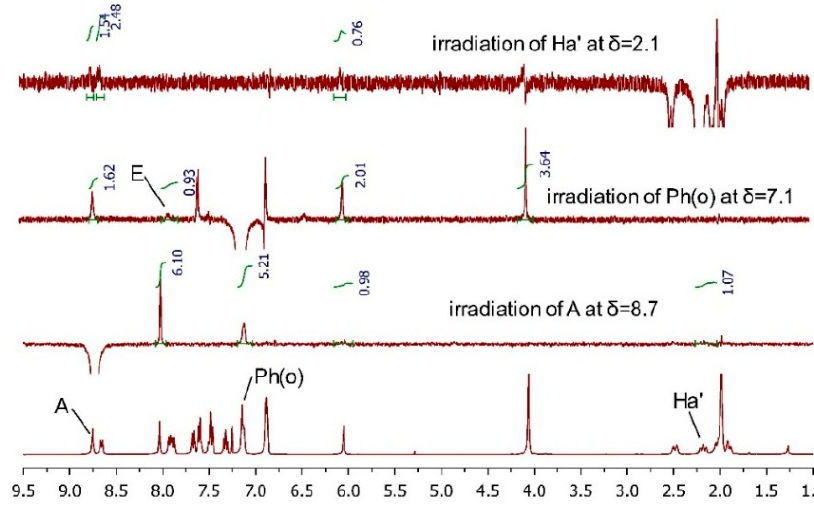
Figure 4. 1D NOESY spectra of TM-05-c .